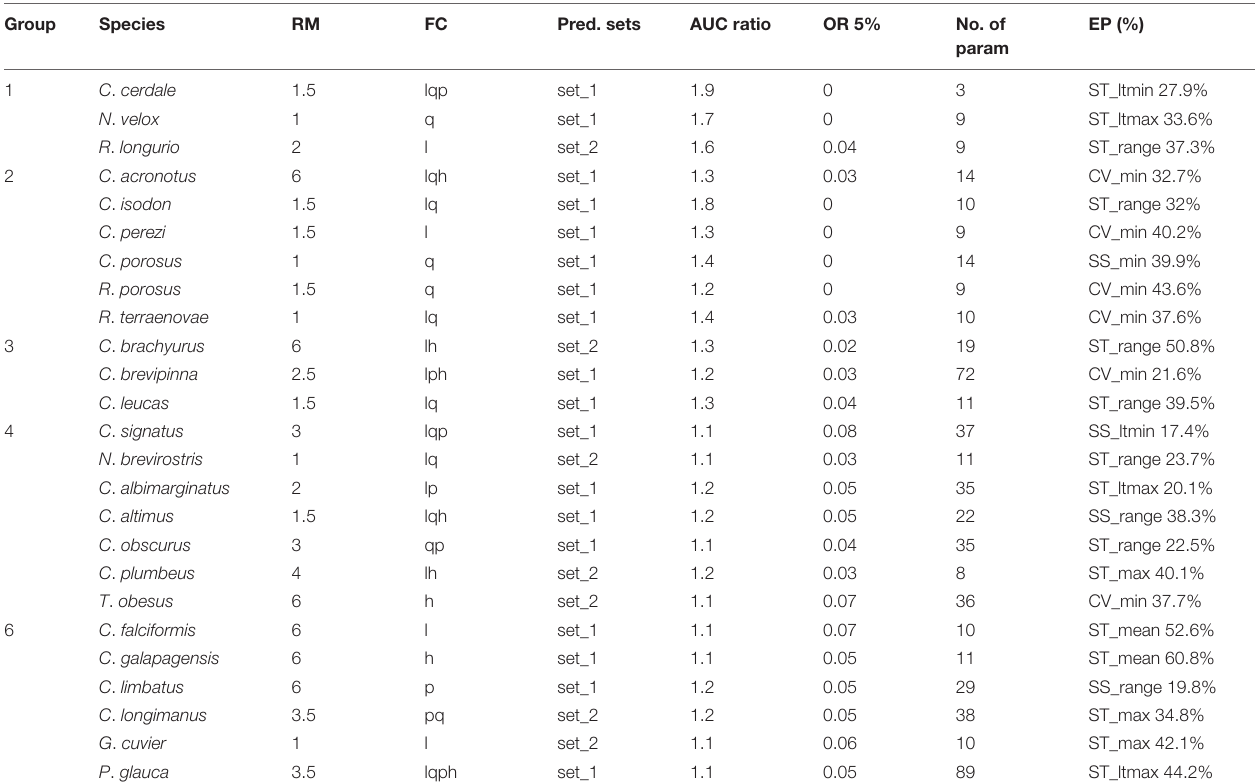
TABLE 2 | Optimal parameters in kuenm models for each species, divided into groups according to their M area: regularization multiplier (RM), feature classes (FC) [linear (l), quadratic (q), product (p), and hinge (h)], set of environmental variables (Pred. Sets), AUC ratio of Partial ROC (AUC), omission rate accepting 5% error in training data (OR ≤